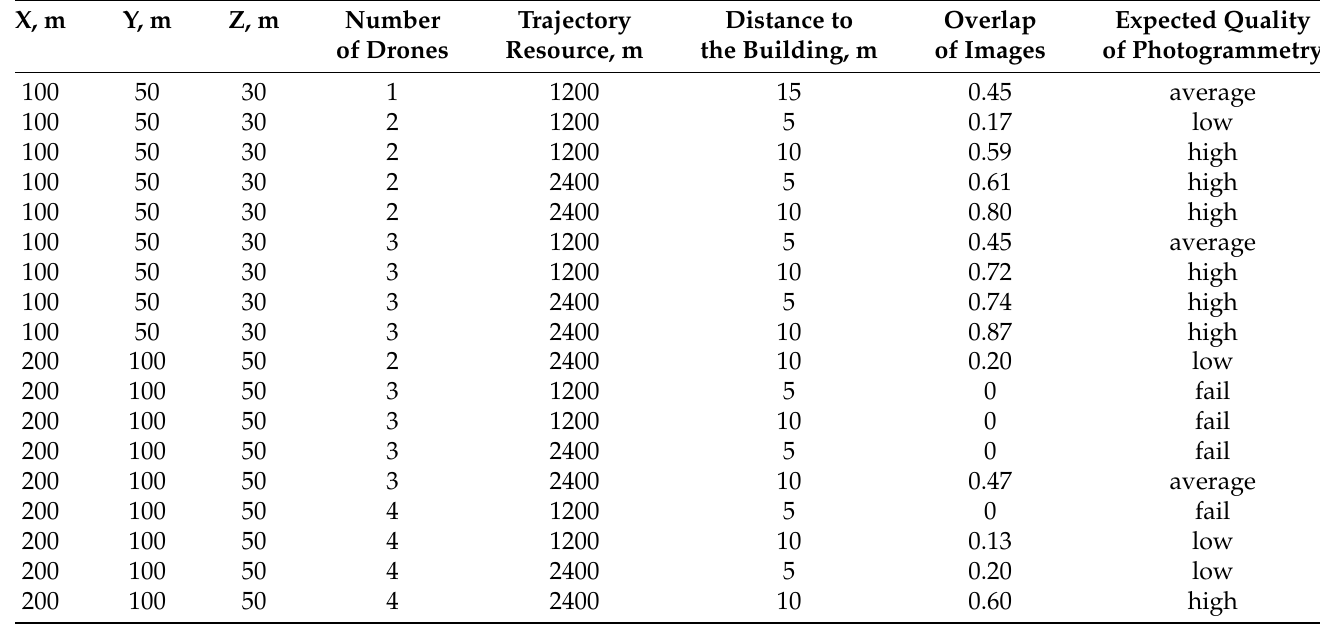
Table 2. Parameter configurations that fit the obtained formulas, where X, Y, Z—building length, width, and height, trajectory resource—the average speed of a drone multiplied to the average battery time